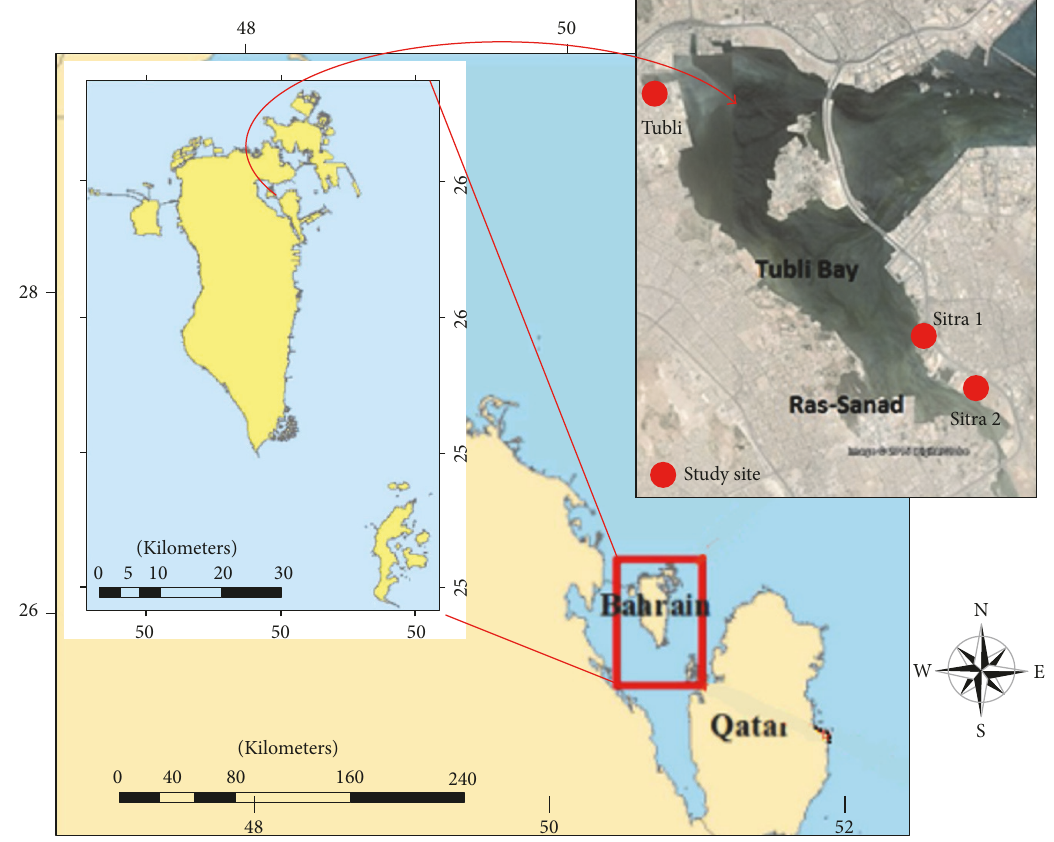
Figure 1: Study site